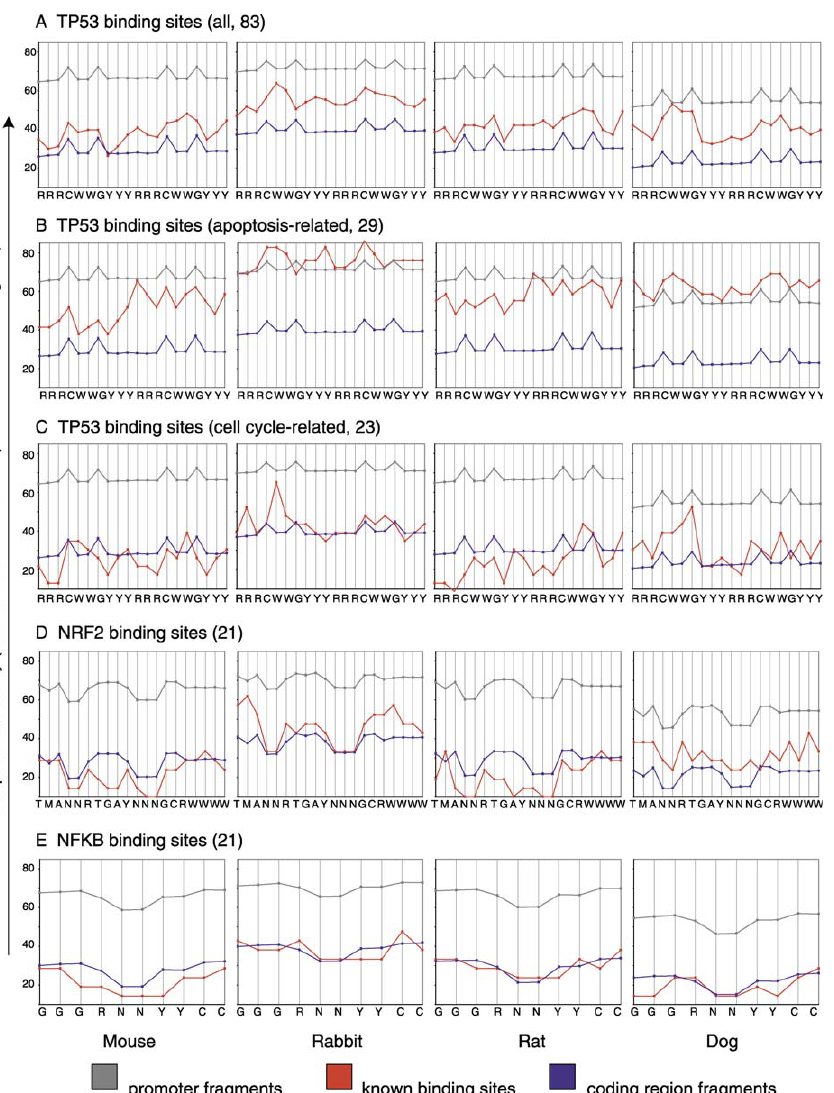
Figure 4. Positional Diversity of Human TFBSs Compared to Four Species (A–E) Sequence diversity is calculated as the percentage of aligned bases at a certain position that vary from the accepted transcription factor consensus sequence, which is listed along the x-axis. The diversity levels of randomly chosen promoter sequences (gray) and randomly chosen coding region (blue) sequences (1,000 trials, error bars are narrower than the data points) are plotted so that level of genuine TFBS diversity (red, known sites) can be viewed in a genomic context. The shape of each plot reflects the level of degeneracy of the consensus at each nucleotide position (e.g., gray line, the p53 consensus has C and G at fixed positions creating peaks in the samples from the promoter)